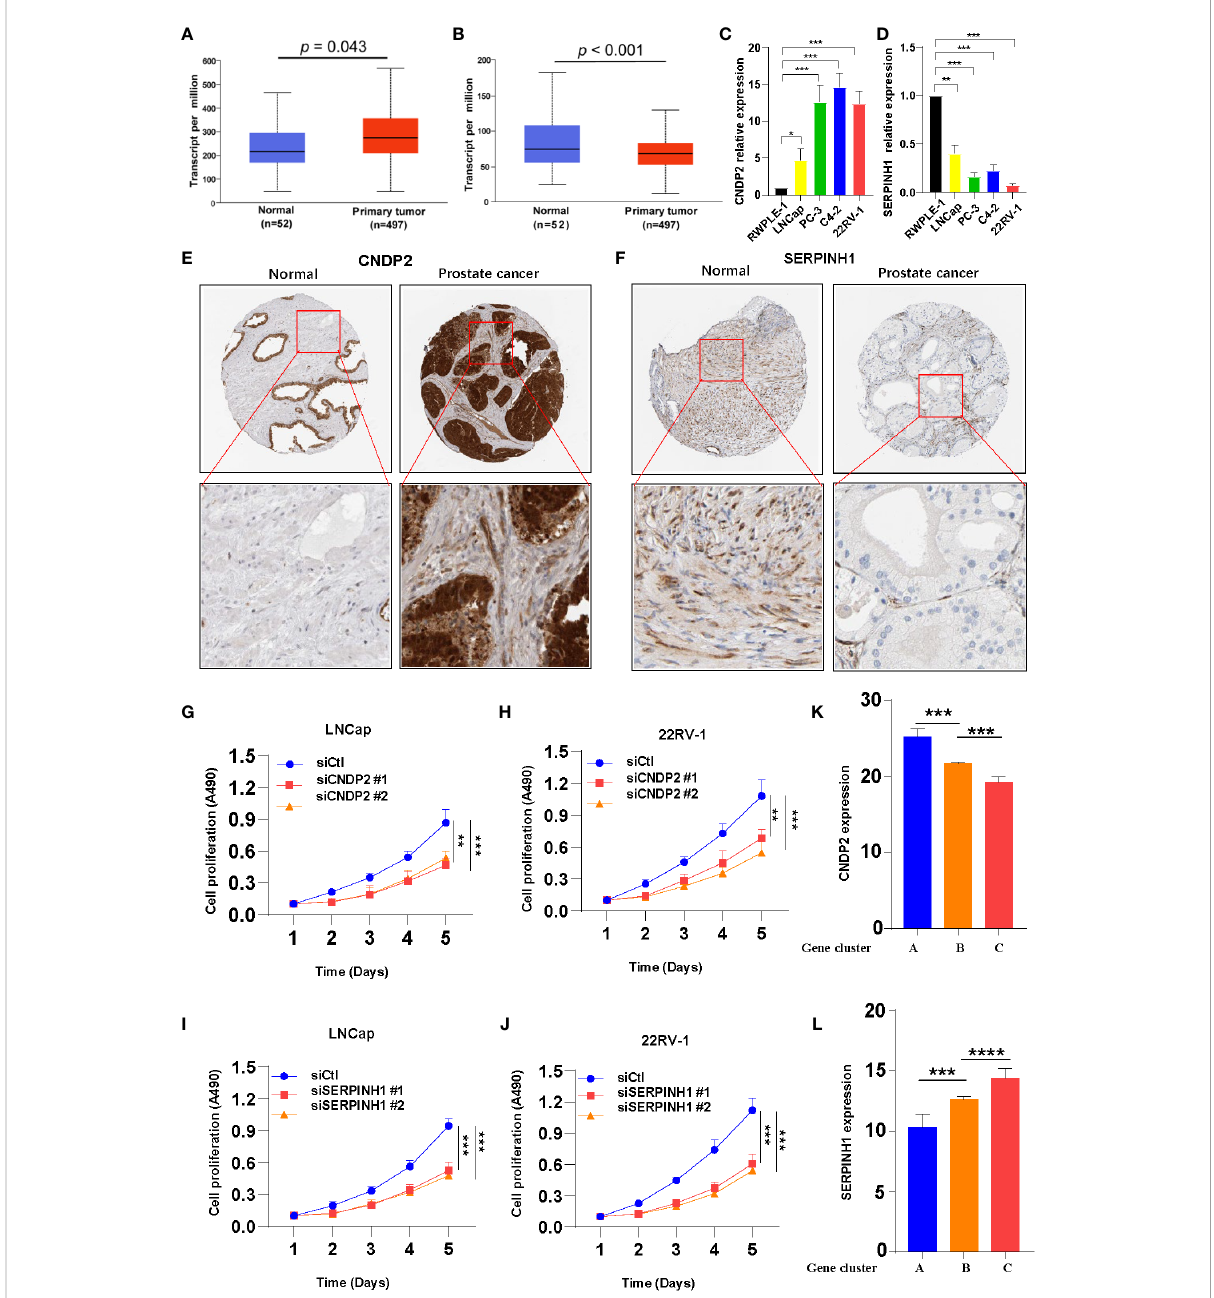
FIGURE 3 Two hub genes were screened from 162 overlapping differentially expressed genes. (A) Increase in CNDP2 mRNA expression in prostate cancer (PC) tissues compared with normal tissues ( P < 0.05; T, tumor; N, normal). (B) Decrease in SERPINH1 mRNA expression in PC tissues compared with normal tissue ( P < 0.05; T, tumor; N, normal). (C, D) qPCR results show the expression of CNDP2 (C) and SERPINH1 (D) in immortalized prostate cell lines (RWPE-1) and PC cell lines (LNCap, PC-3, C4-2, and 22RV-1). (E, F) Immunohistochemistry results showing the expression of si CNDP2 (E) and SERPINH1 (F) in prostate tumor tissue and normal prostate tissue. (G, H) The results of the cell proliferation assay show that si CNDP2 could suppress the proliferation of LNCap (G) and 22RV-1 (H) . (I, J) The results of the cell proliferation assay show that siSERPINH1 could suppress the proliferation of LNCap (I) and 22RV-1 (J) . (K) CNDP2 expression was highest in gene cluster (A, L) SERPINH1 expression was the highest in gene cluster (C) * P < 0.05, ** P < 0.01, *** P < 0.001, ****P<